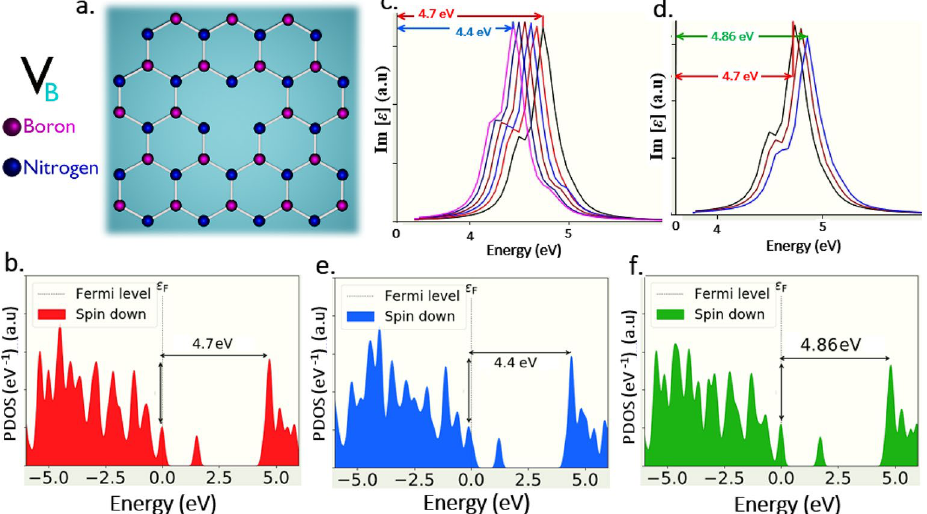
Figure 10. DFT computed V B defect, their tunable quantum emission towards lower and higher energy regions and corresponding PDOS. ( a ) Schematic illustration of V B (boron mono vacancy) whose ZPL energy is observed at 4.7 eV. ( b ) PDOS of V B defect under no external strain, whose possible electronic transition energy difference between inter energy states is consistent with ZPL energy (4.7 eV), which ensures the quantum emission. ( c , d ) Quantum emission tunability towards lower and higher energy region for applied positive and negative biaxial strains respectively. Red colour arrow indicates the quantum emission peak (ZPL) at 4.7 eV under no strain condition. Blue colour arrow indicates tuned quantum emission peak (tuned ZPL) up to 4.4 eV (towards lower energy region) for applied positive biaxial strain. Green colour arrow indicates tuned quantum emission peak (tuned ZPL) up to 4.86 eV (towards higher energy region) for applied negative biaxial strain. The colours were reflected in PDOS information also. Optical spectrum graphs were obtained by assigning y-axis to imaginary component of dielectric constant [ ε ] and x-axis to energy (eV). ( e , f ) Corresponding PDOS of positive and negative biaxially strained V B defect, whose energy differences consistent with tuned quantum energies, which ensures the efficient tunability of quantum emission and bandgap